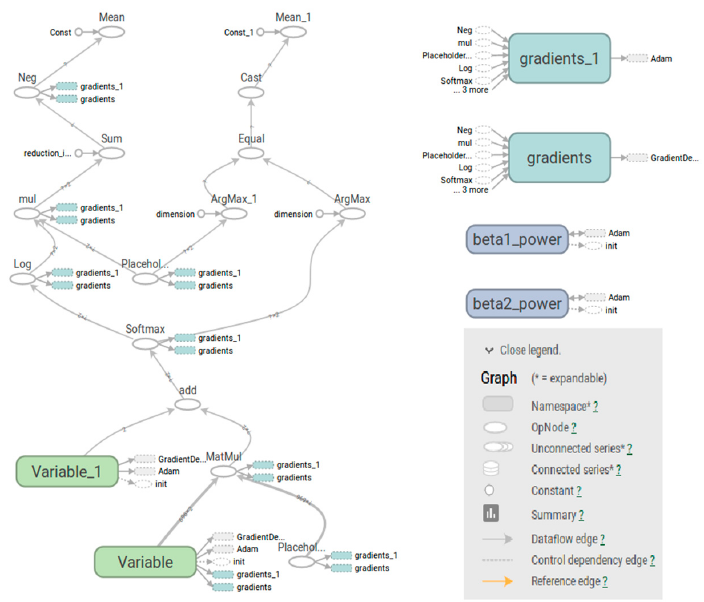
Figure 5. Structure using Adam.